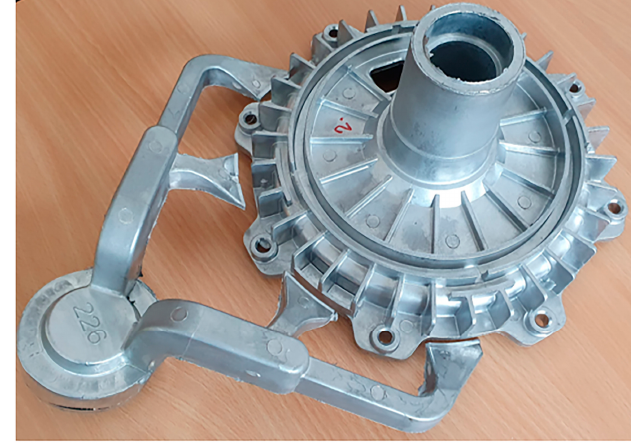
Figure 3. Casting of SB 55 variant with gating system.